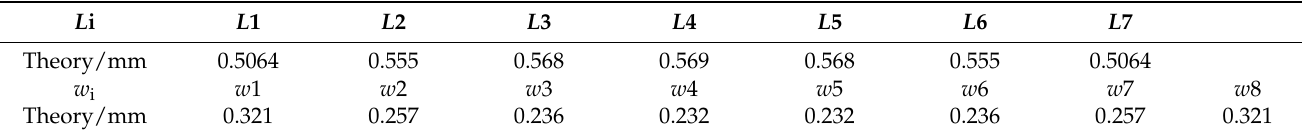
Table 2. Theoretical values of structural parameters of 336–364 GHz